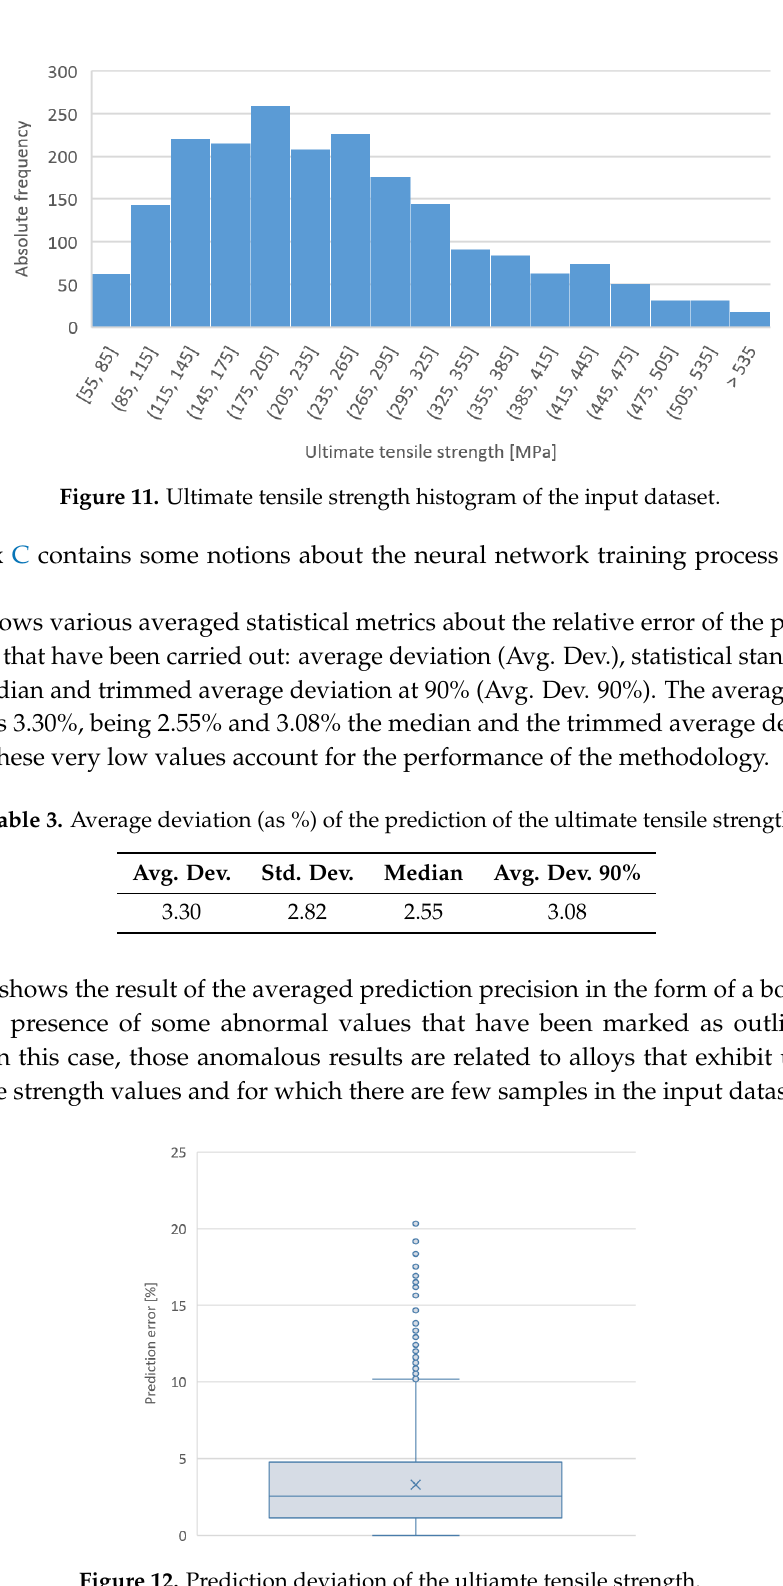
Figure 12. Prediction deviation of the ultiamte tensile